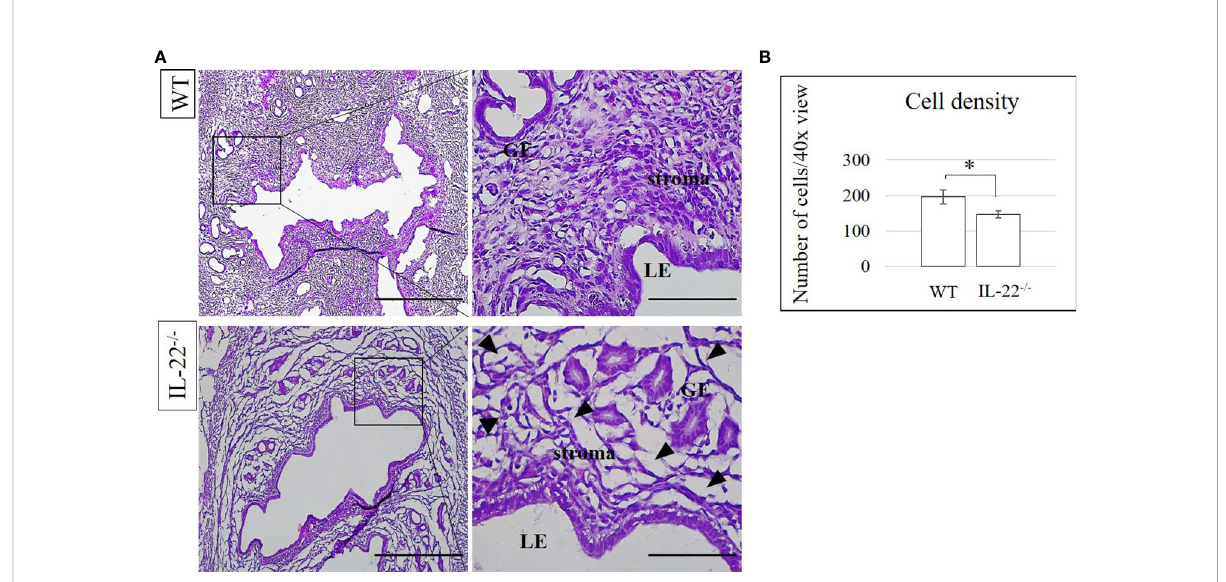
FIGURE 7 The density of cells in IL-22 − / − and WT mice. (A) IL-22 − / − , n = 6, and WT, n = 5, mouse uterine samples were harvested 48 h post intraperitoneal LPS injection, frozen fi xed, and processed for H&E analysis. Black arrowheads are pointing at the spaces in uterine stroma ( “ stromal edema ” ). (B) Cell density was calculated by Cell Counter Plugin in ImageJ software to measure whether the difference between the groups is statistically signi fi cant. The data from t-test are provided as mean ± SEM. WT, wild type; IL-22 − / − , IL-22 knockout; LPS, lipopolysaccharide. Original magni fi cation, ×10 and ×40. Scale bar, 100 µm. * p <